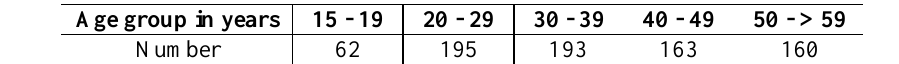
Table II : Marital status per sex